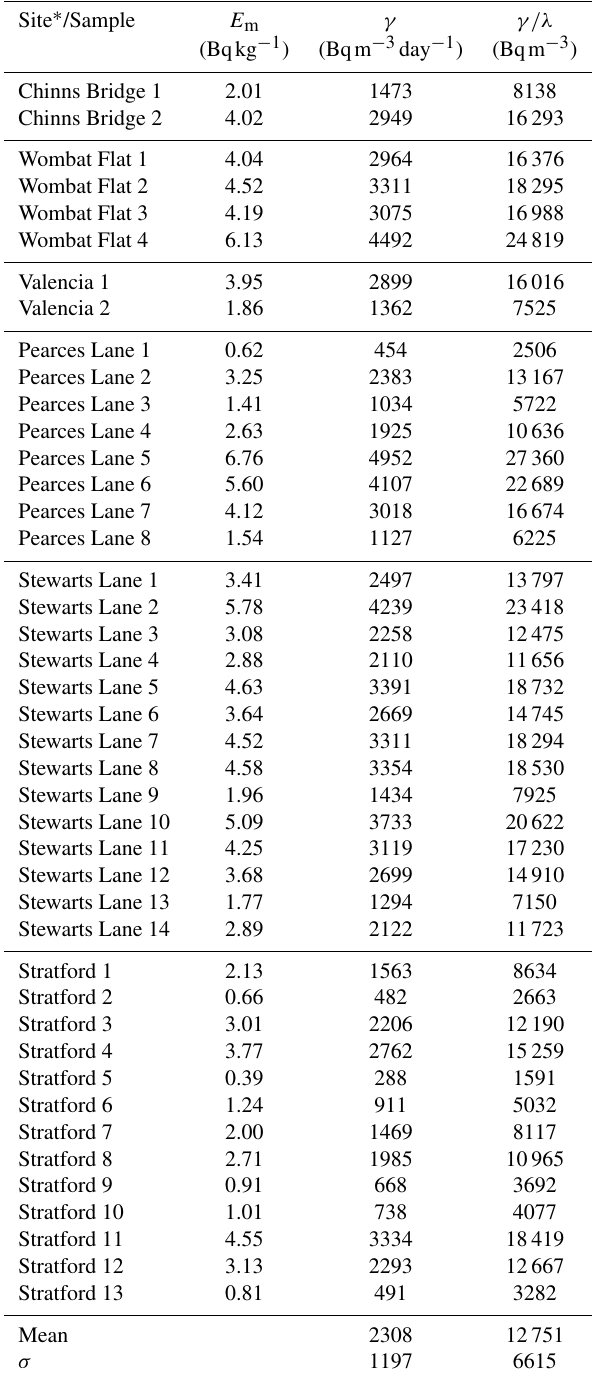
Table 2. 222 Rn emanation rates from floodplain sediments.